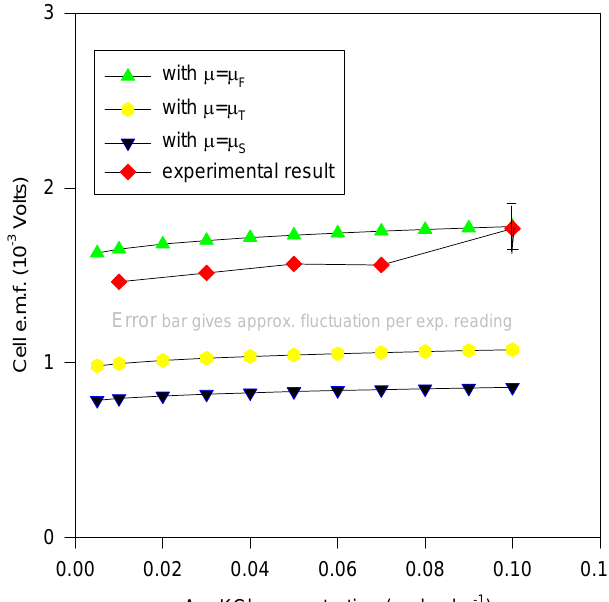
Figure 9 . Cell e.m.f. based on H